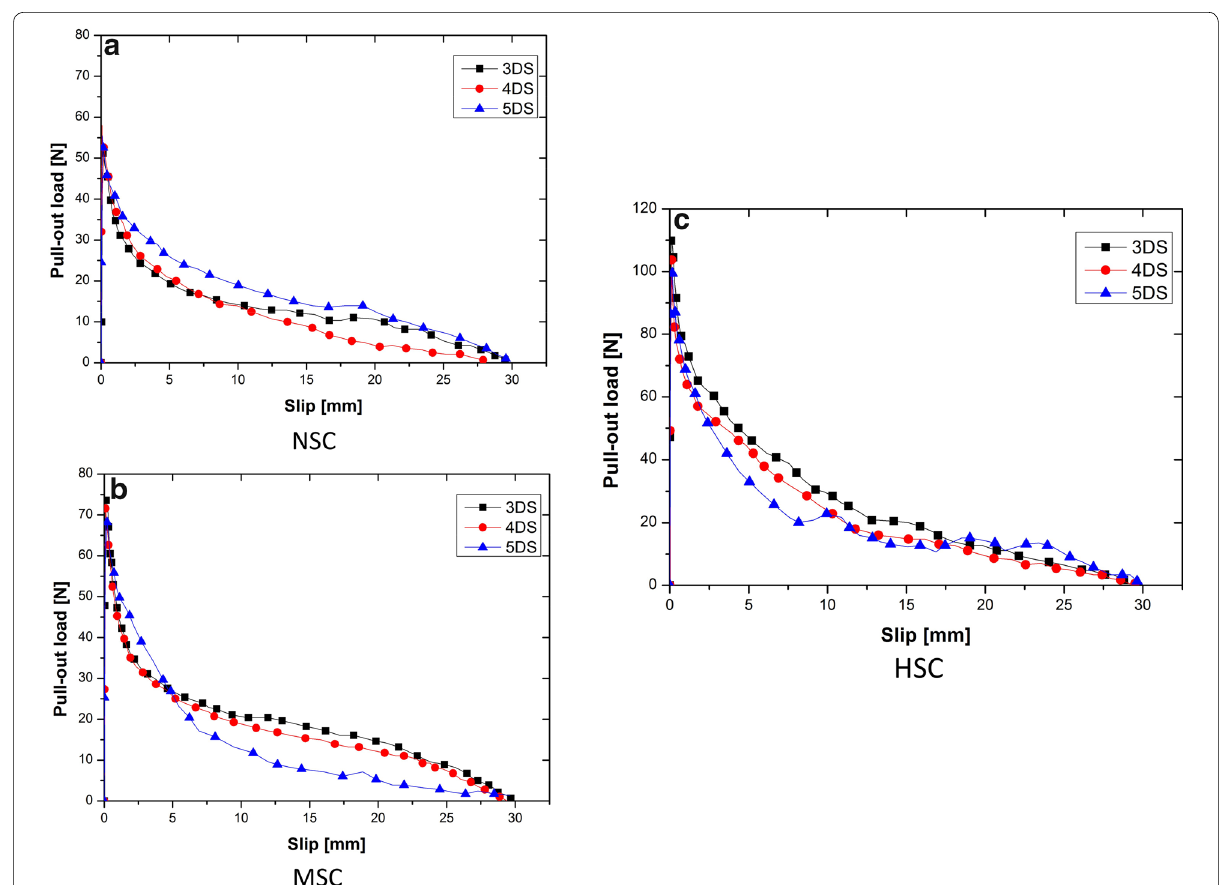
Fig. 4 Average pull-out-slip response of straight steel fibres. a NSC, b MSC and c HSC.